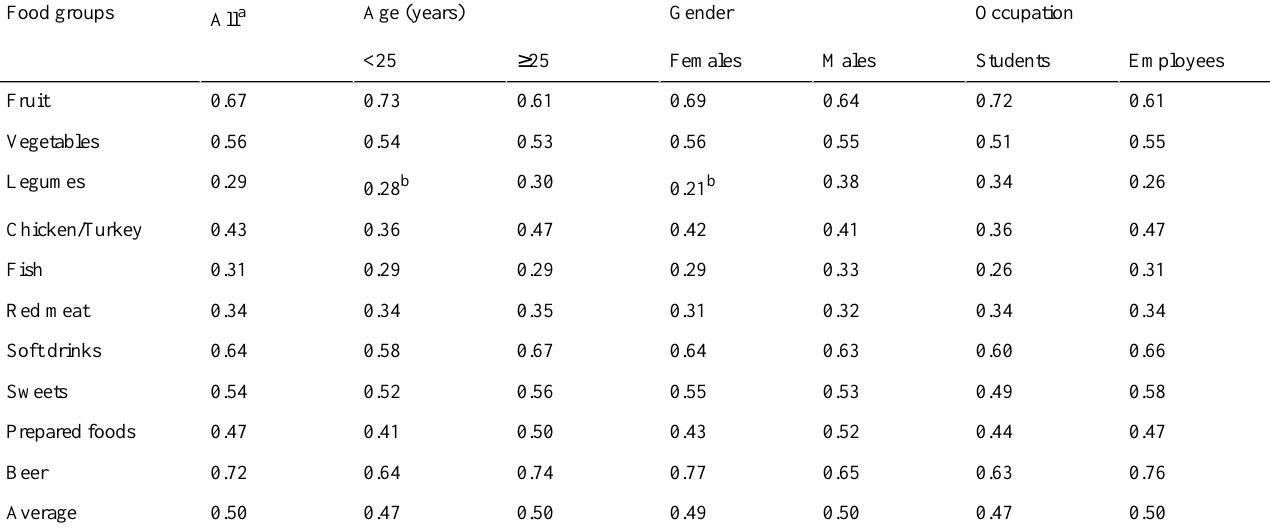
Table 12. Weighted kappa derived from the electronic 12-hour dietary recall app versus the 4 dietary records for categories of food group consumption and strata: age (years): <25 and ≥ 25; gender: females and males; and occupation: students and employees. Comparison of the electronic 12-hour dietary recall app versus dietary